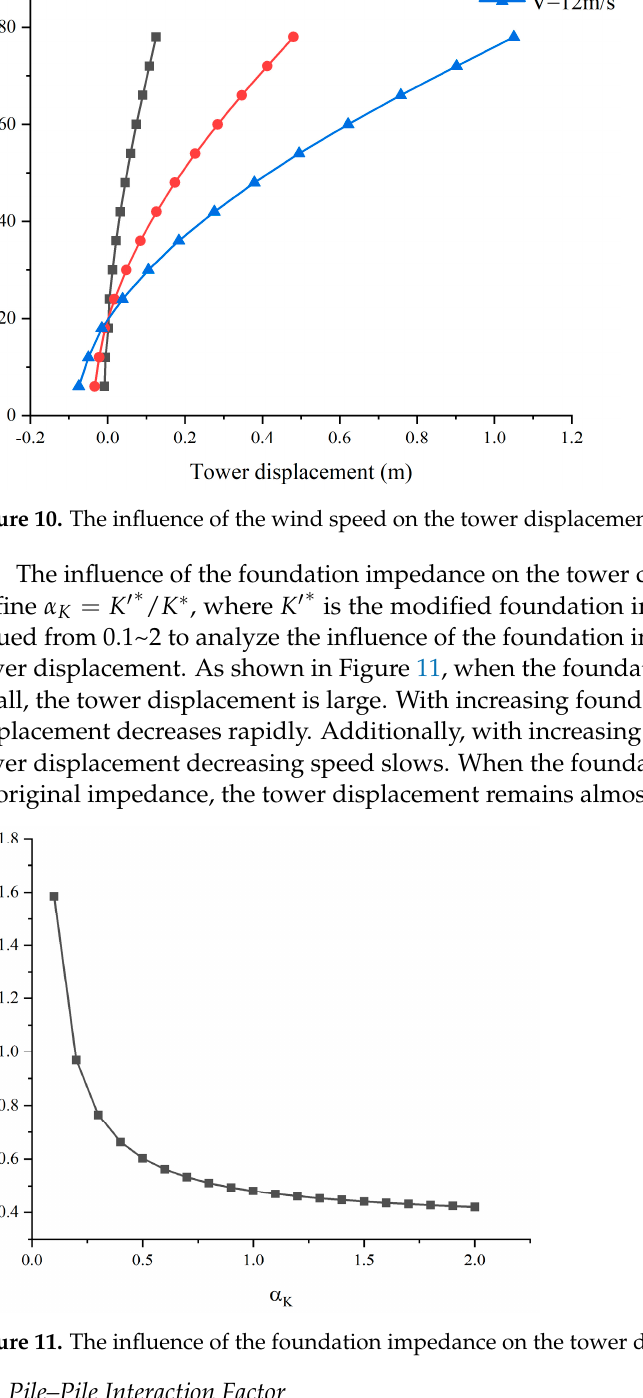
Figure 11. The influence of the foundation impedance on the tower displacement.